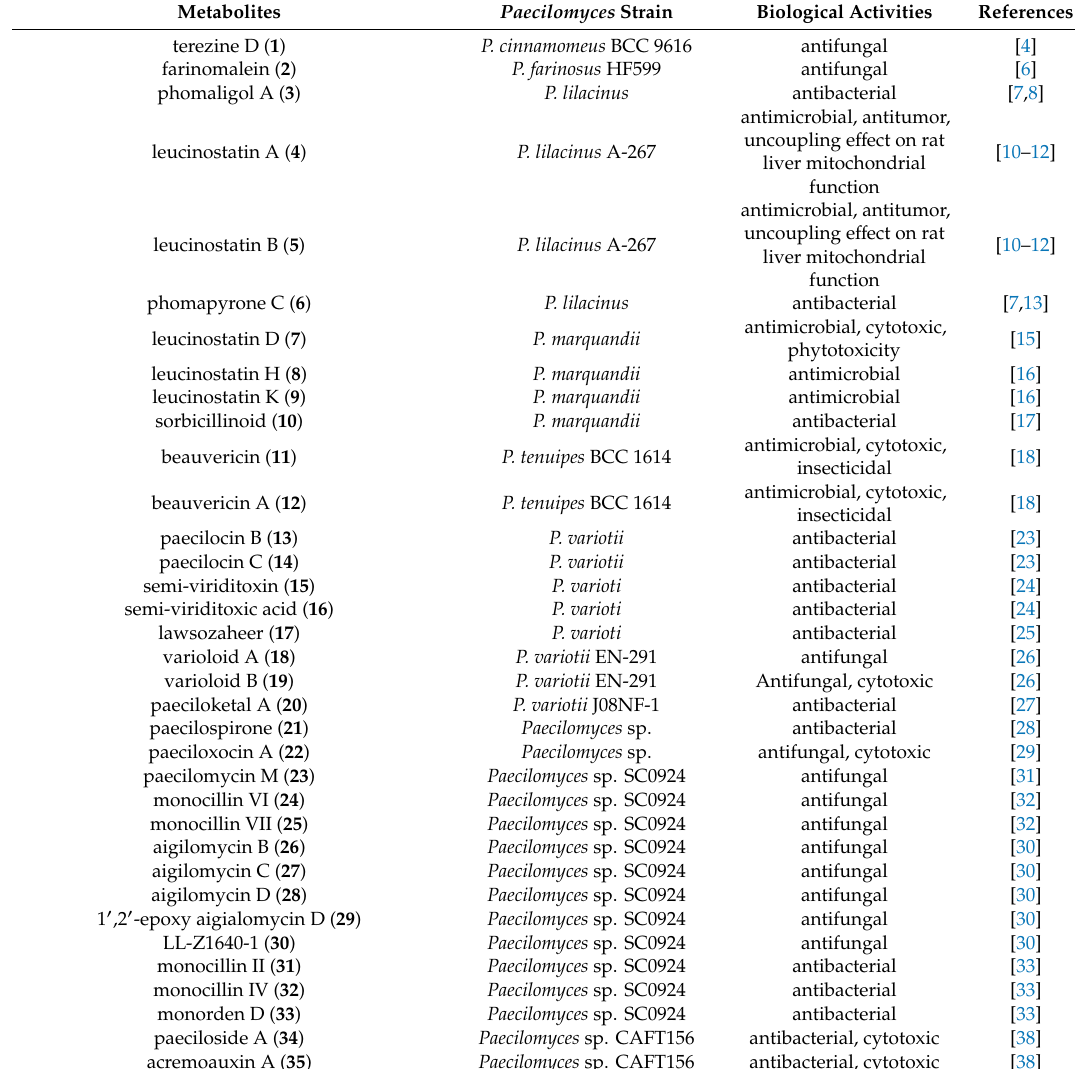
Table 1. The active metabolites derived from Paecilomyces